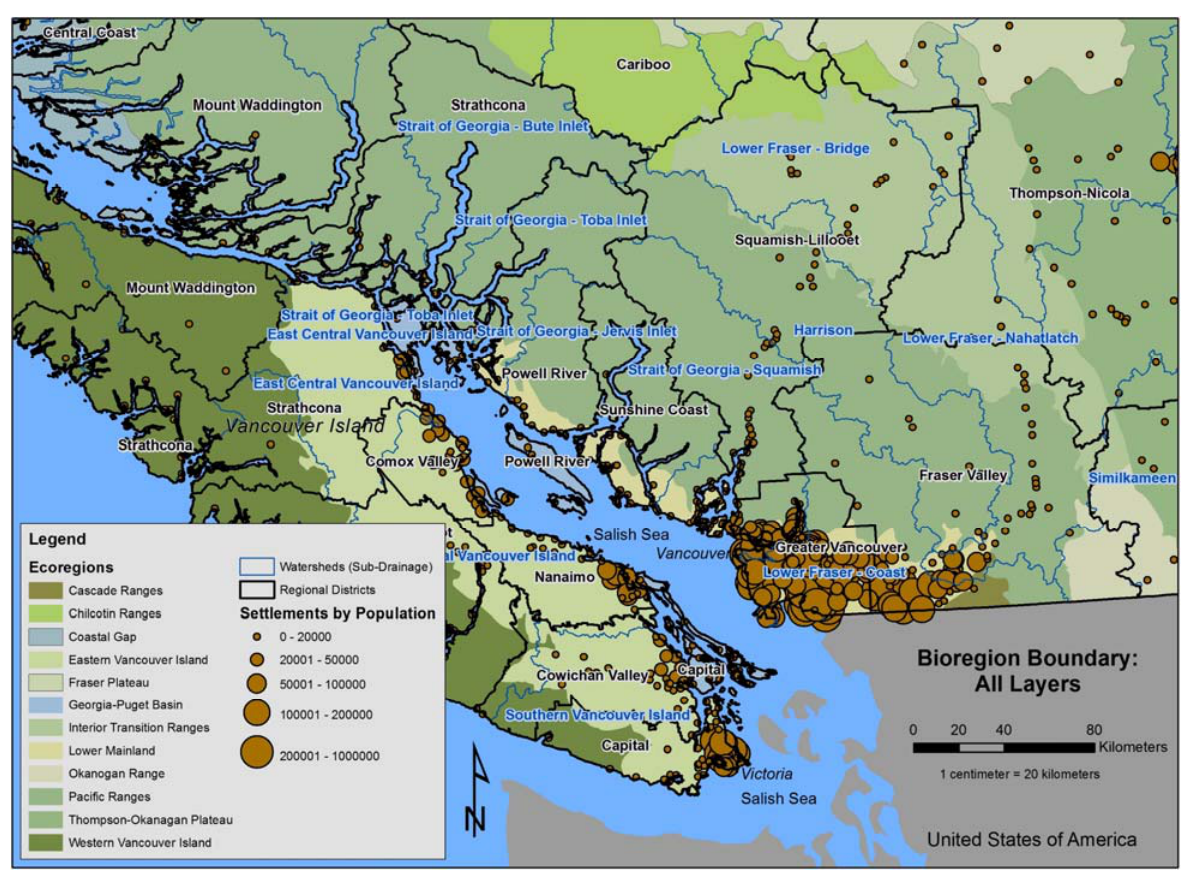
Figure 4. The Southwest British Columbia (SWBC) Bioregion Layers. Composite map showing geopolitical boundaries and all other layers (except transport